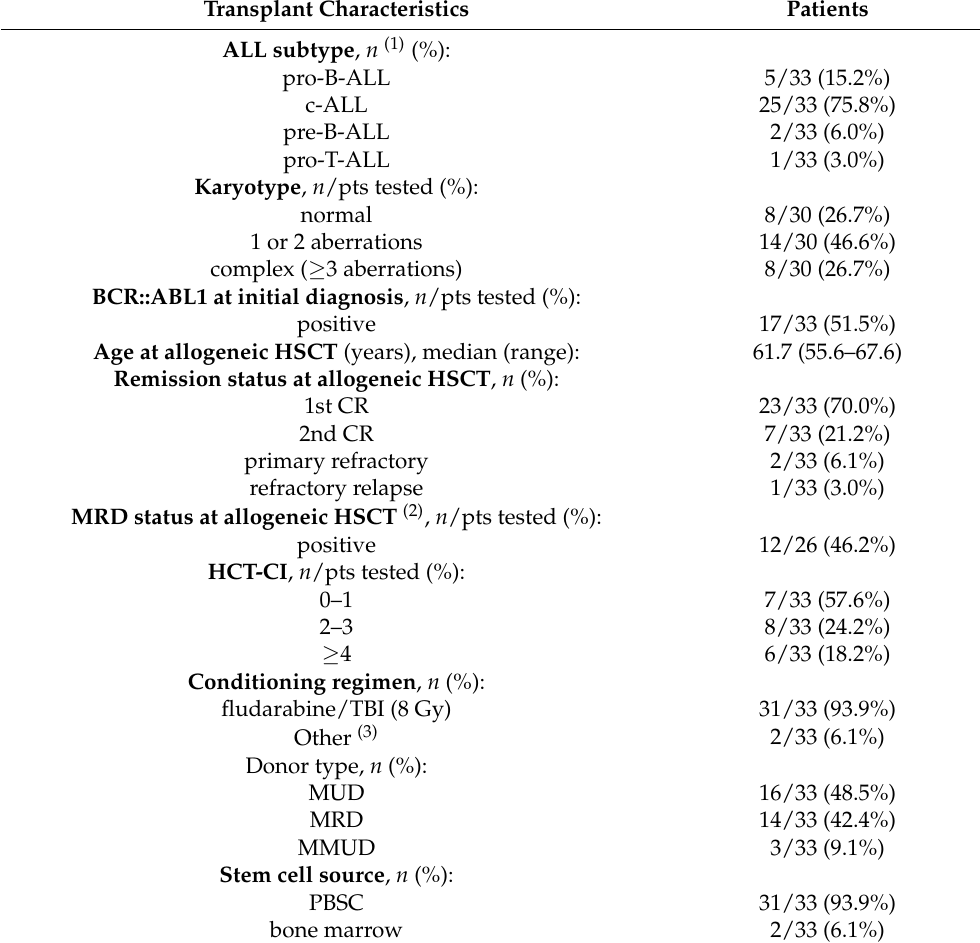
Table 4. Transplant characteristics of ALL patients > 55 years with B-precursor or T-ALL receiving allogeneic HSCT (33